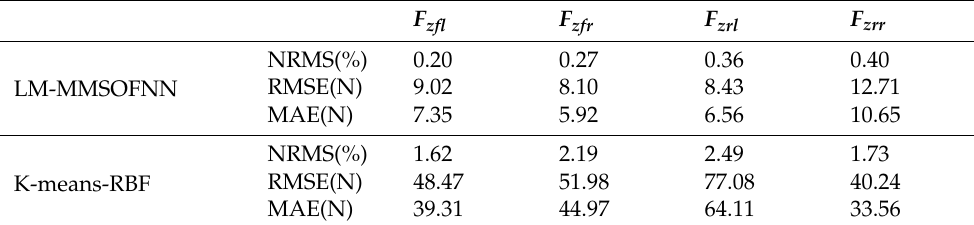
Table 10. Vertical tire force estimation errors of LM-MMSOFNN and K-means-RBF. F